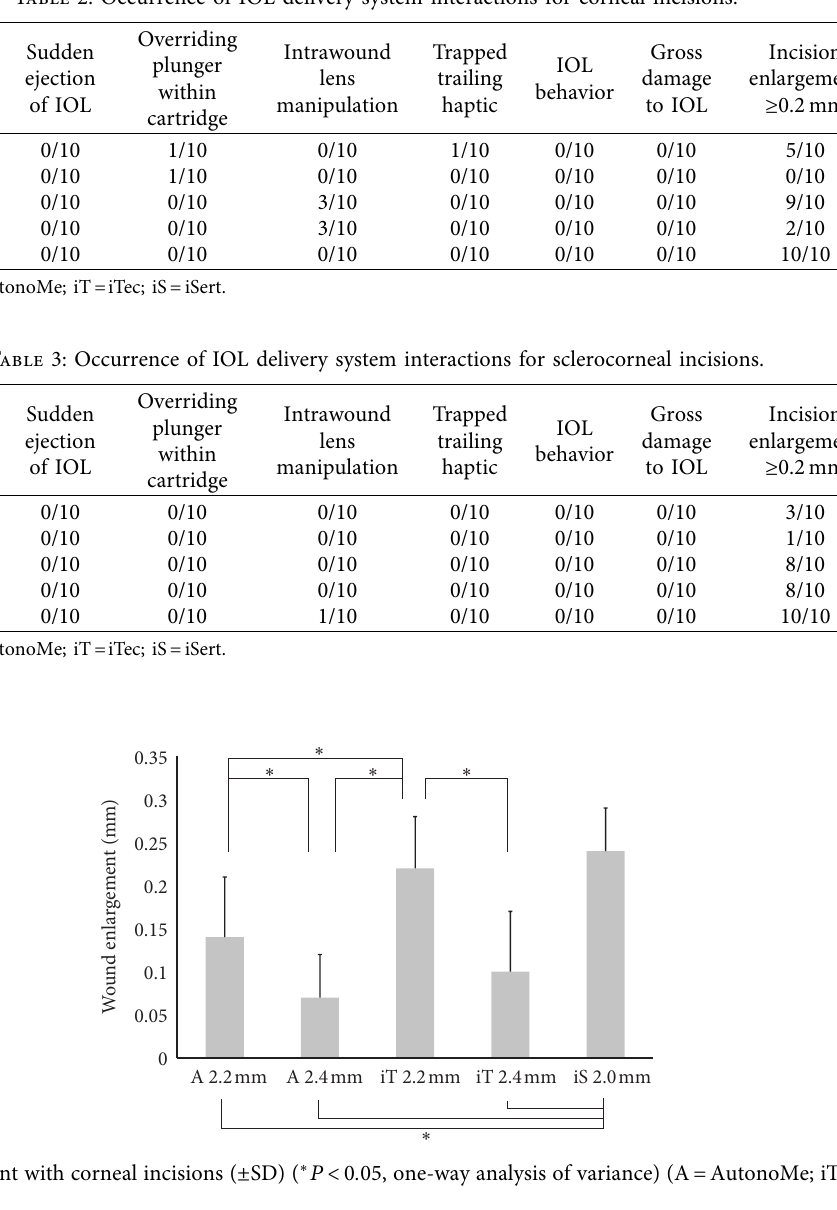
Table 2: Occurrence of IOL delivery system interactions for corneal incisions.